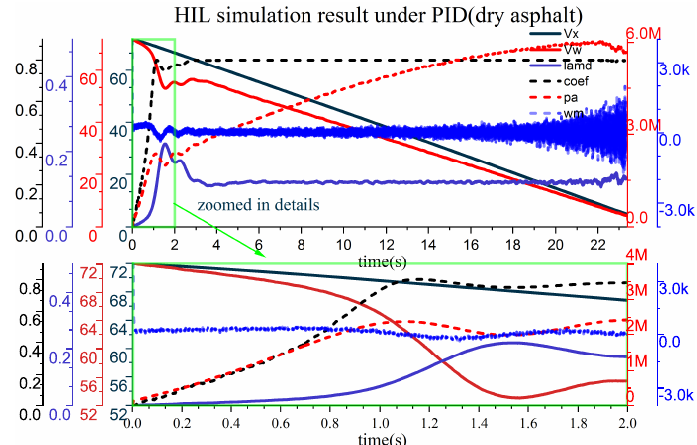
Figure 15. HIL experimental results of the PID algorithm.